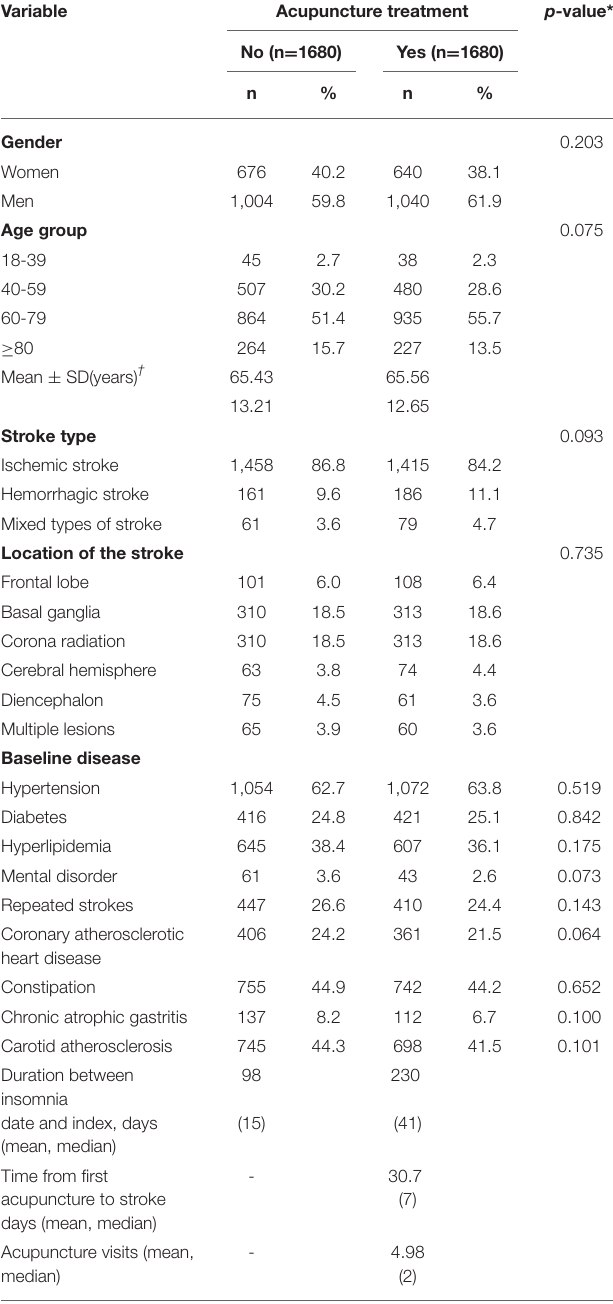
TABLE 1 | Characteristics of stroke patients based on the factors of whether accepted